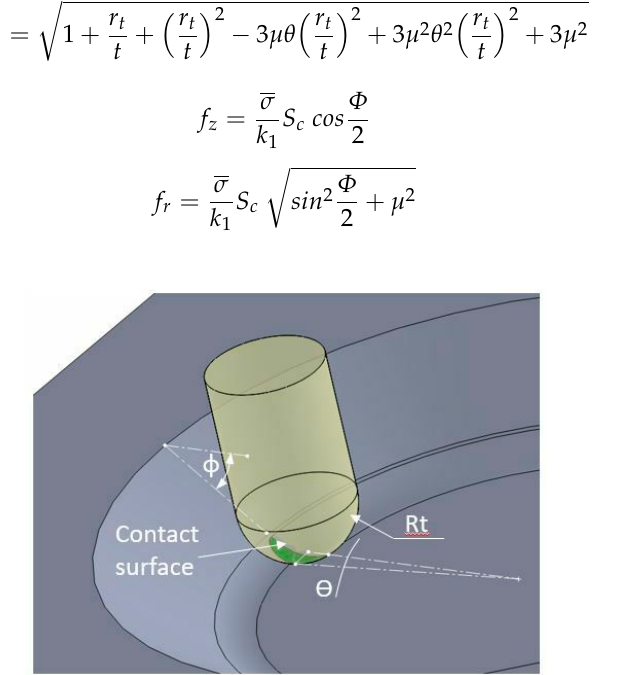
Figure 17. Analytical parameters for the model of the tool-formed part contact. Metals 2019 , 9 , x FOR PEER REVIEW